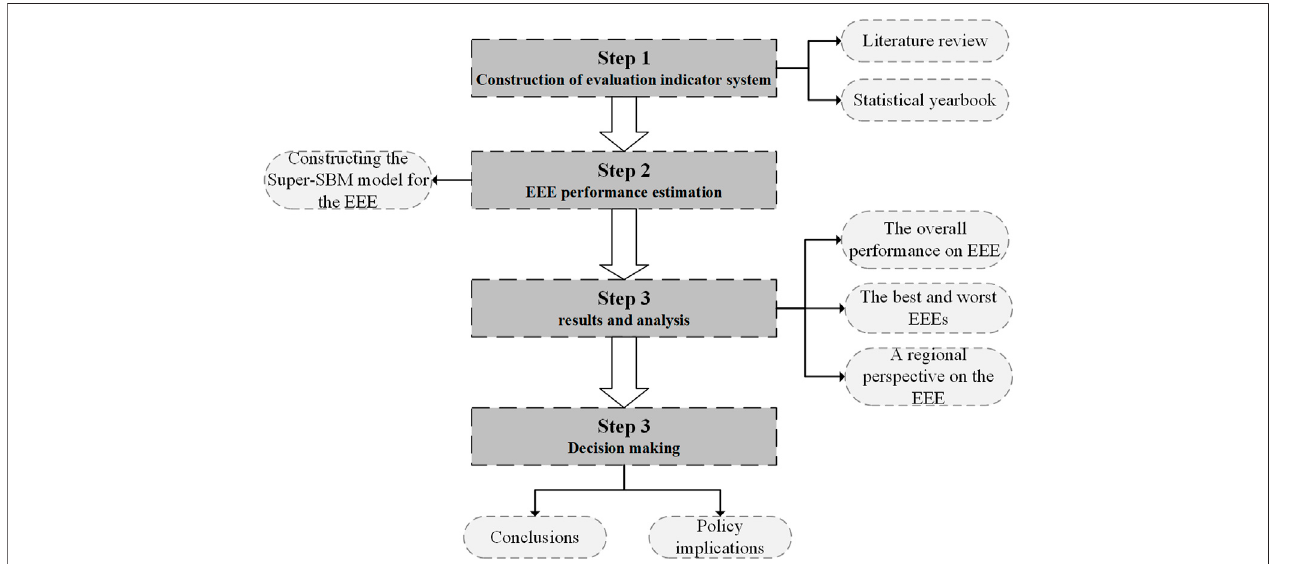
FIGURE 1 | The fl owchart of the transportation systems ’ EEE research